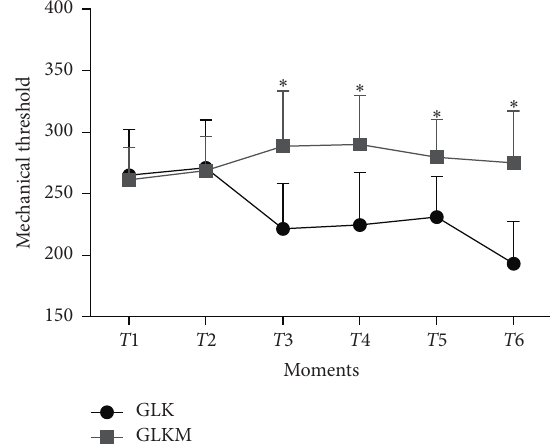
Figure 4: Mean ± standard error of the mean of using the digital analgesimeter at the secondary points for pain evaluation in female dogs submitted to unilateral radical mastectomy, continuous in- fusion of lidocaine and ketamine (GLK), and continuous infusion of lidocaine, ketamine, and maropitant (GLKM) during the six moments of postoperative